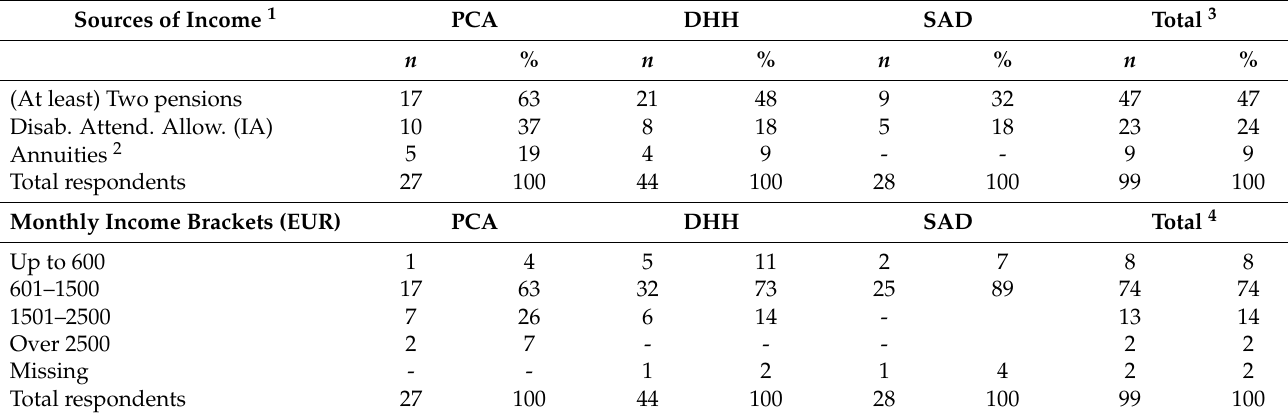
Table 6. Care networks and income of